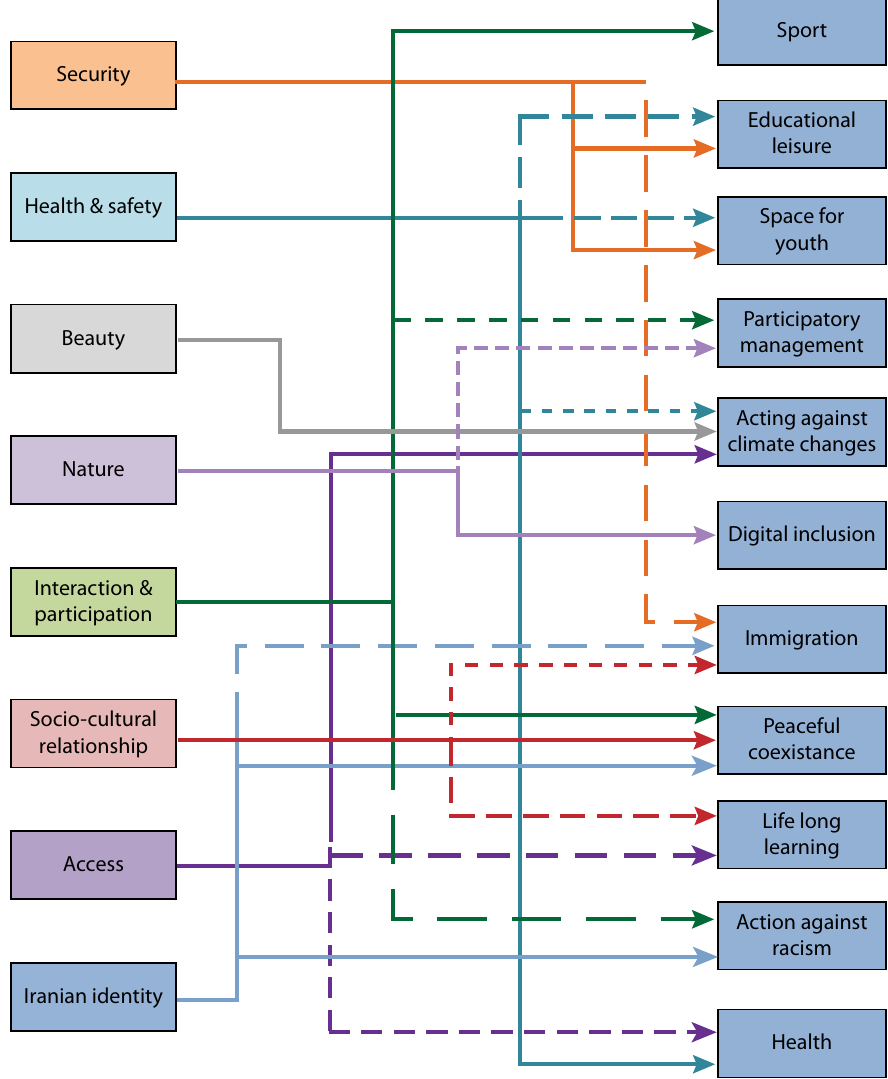
fig. 6. Iranian criteria in educating cities